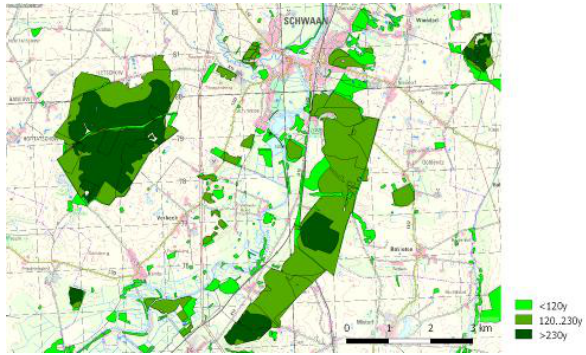
Figure 7. Forest zones in different age classes.